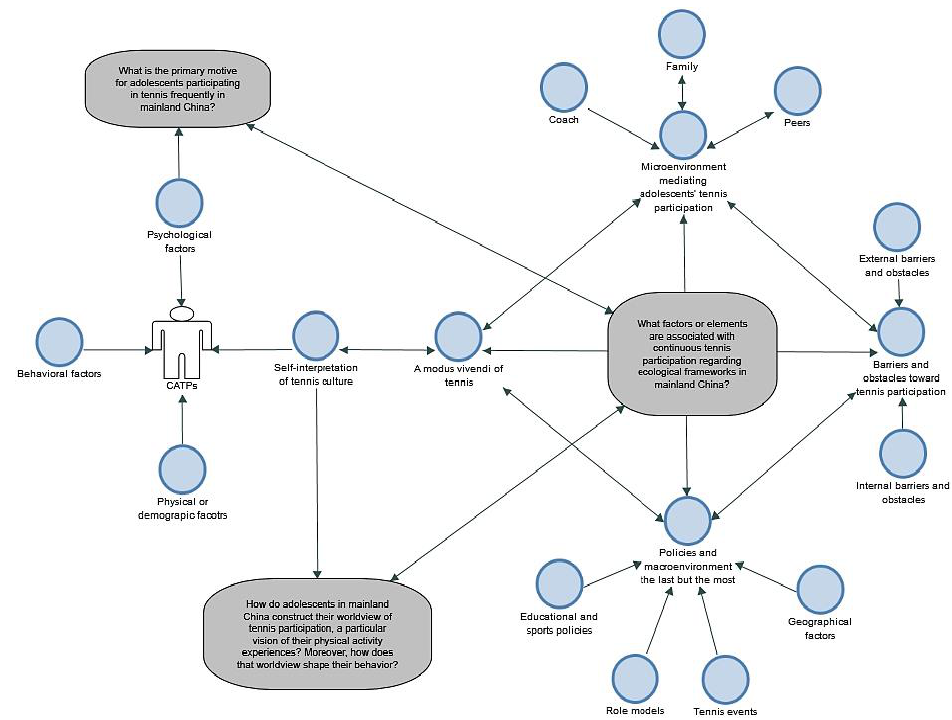
Figure 2. Thematic framework of merged themes and research questions.